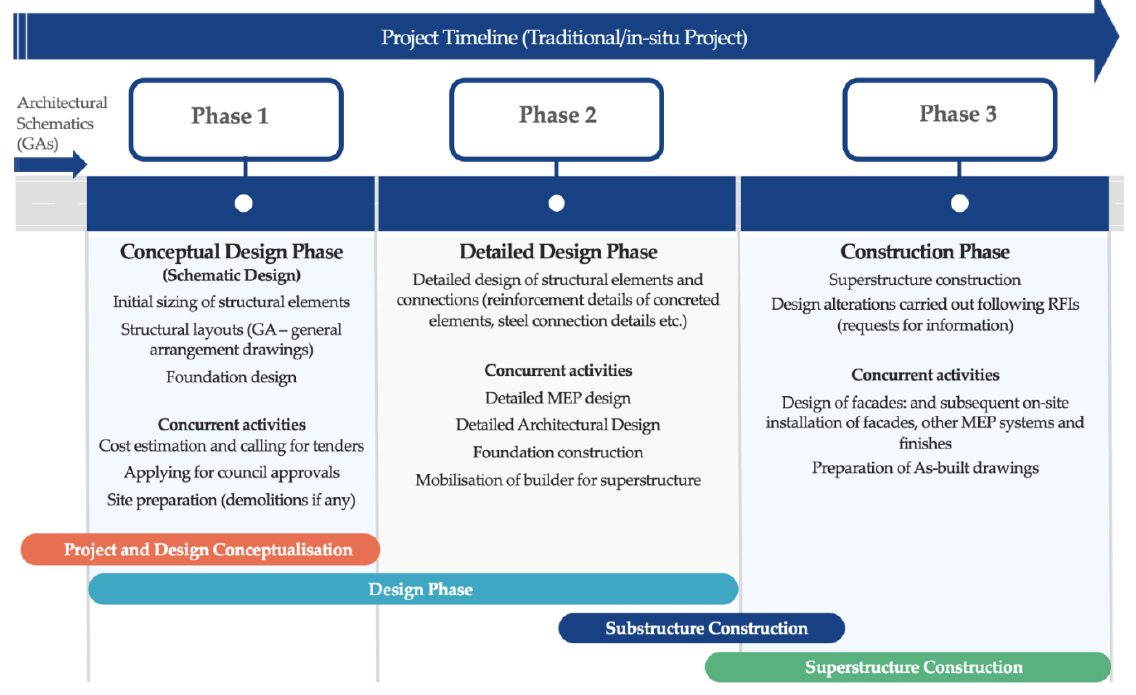
Figure 2. Phases in a traditional structural design process for an in-situ construction alongside other related activities that occur concurrently with each phase of the project.